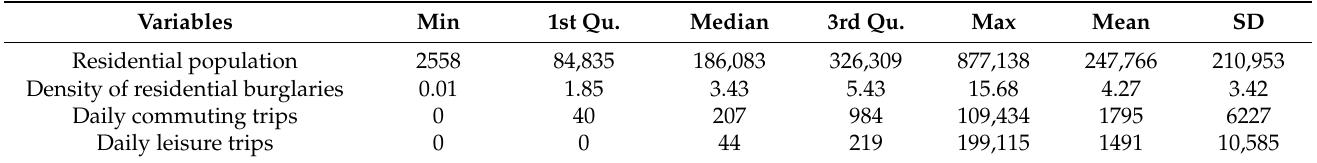
Table 1. Descriptive statistics of